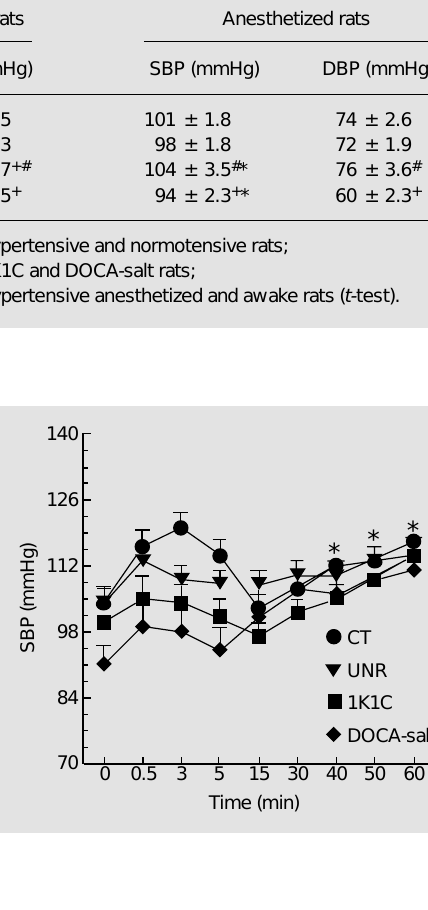
Table 1. Systolic (SBP) and diastolic (DBP) blood pressure in normotensive (control, CT; uninephrectomized, UNR) and hypertensive (1K1C and DOCA-salt) awake and anes- thetized rats.